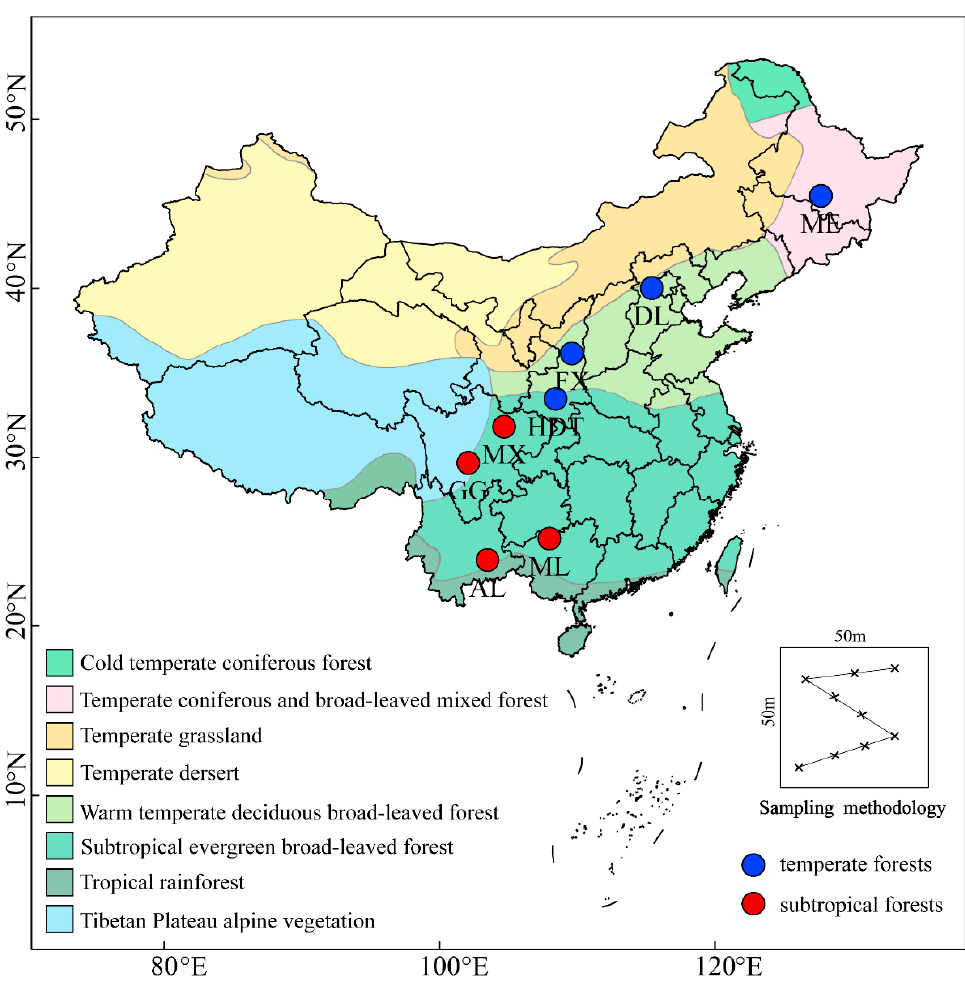
Figure 1. Distribution of sampling sites along the subtropical–temperate forest biomes of China. The abbreviations of sampling sites from north to south are as follows: ME, ME, and Maoer mountain; DL and Dongling mountain; FX and Fuxian; HDT Huoditang; MX and Maoxian; GG and Gongga mountain; AL and Ailao mountain; ML and Karst Mulan Station.